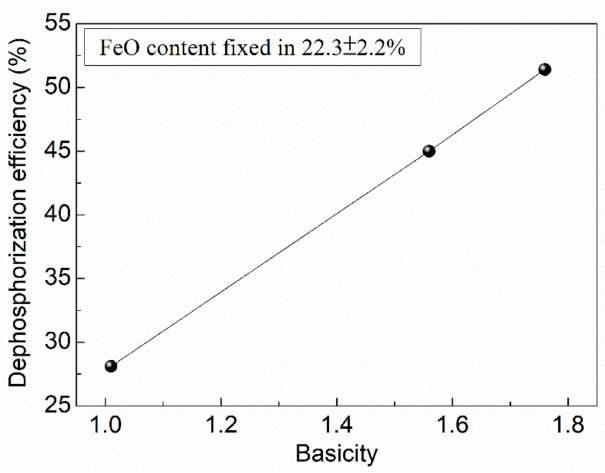
Figure 12. Relationship between dephosphorization efficiency and slag